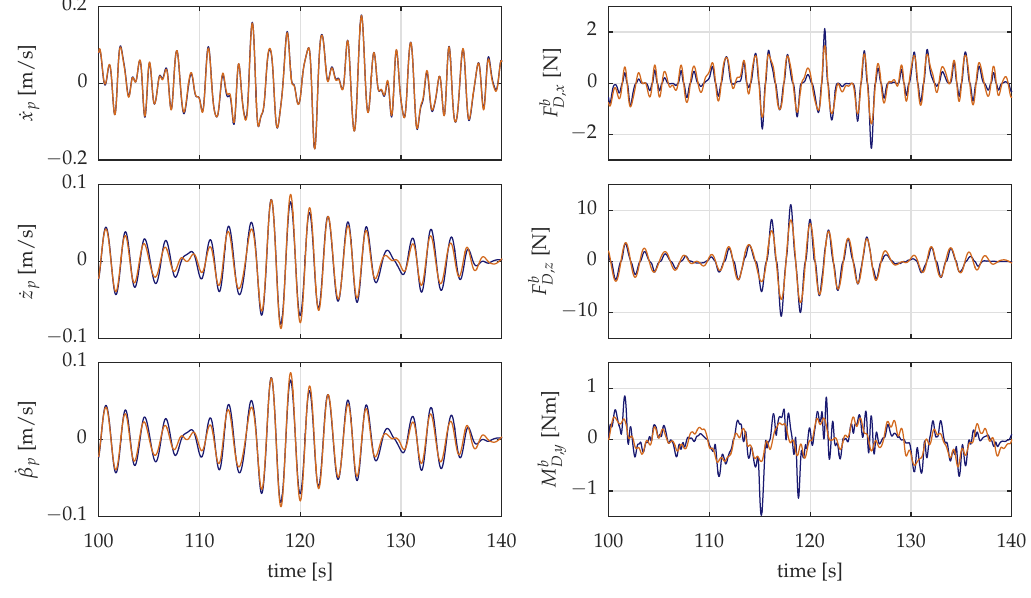
( t ) , nonlinear (dark blue) and linearized (light D